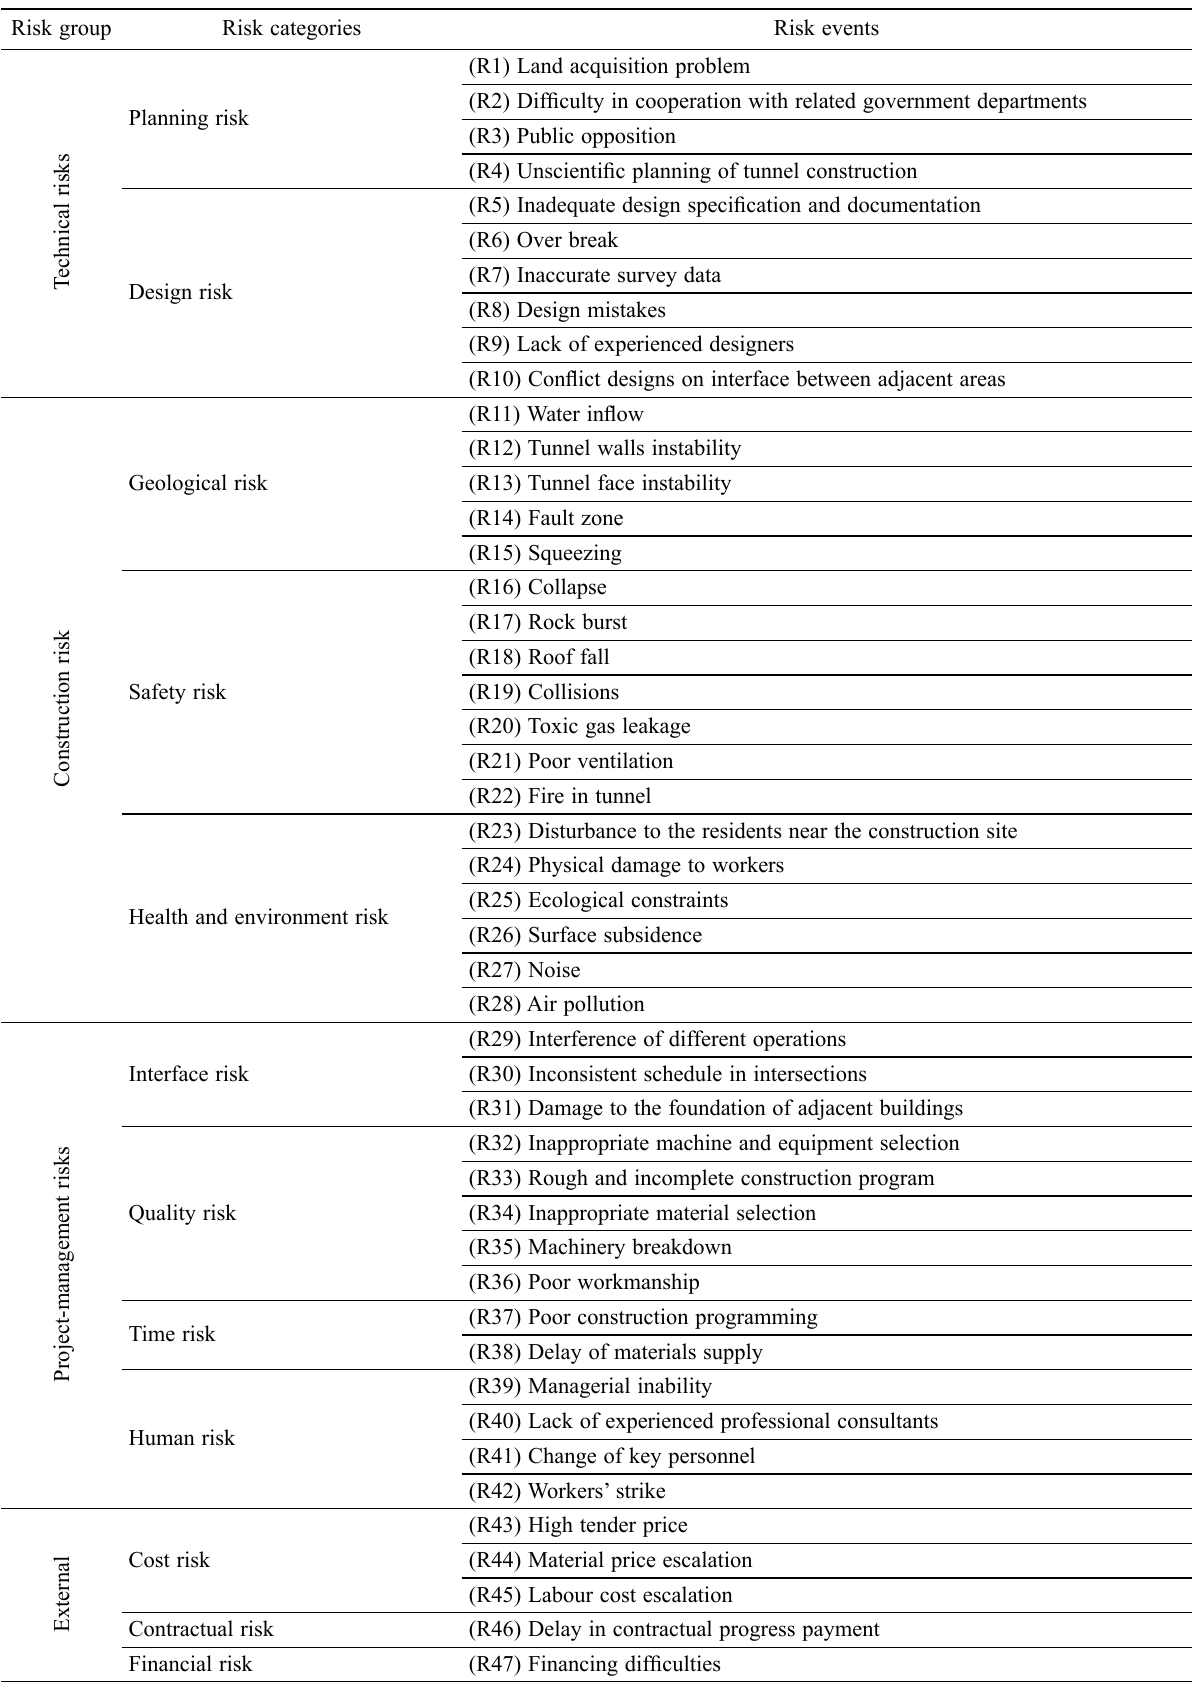
Table 4. List of the risks identified Risk